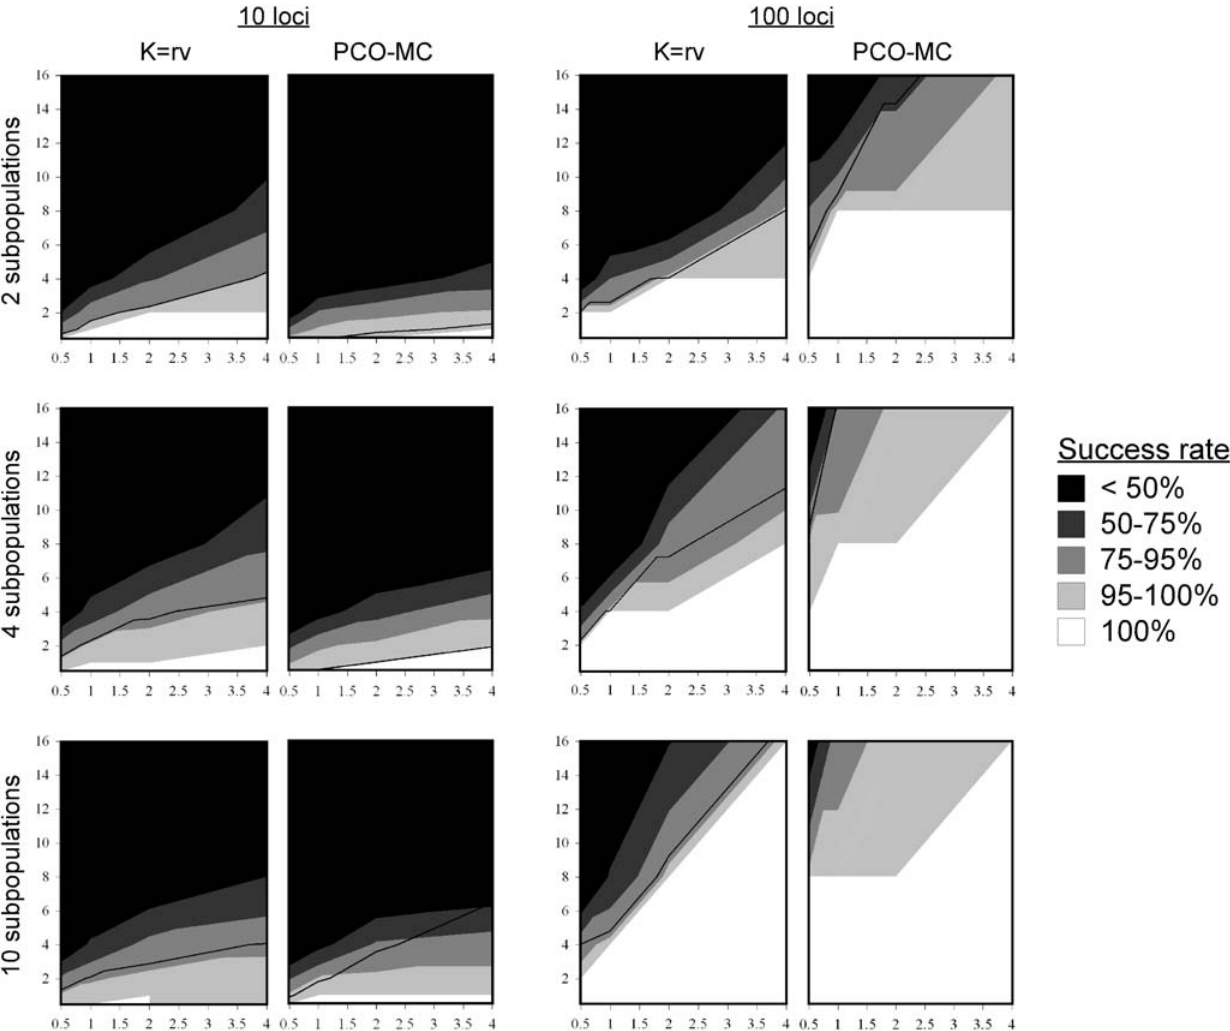
Figure 6. Relative performance of K=rv and PCO-MC methods for population structure inference using simulated data. X axes=mutation rate ( h ), Y axes=migration rate (M). Contour intervals are shaded according to the probability of successful inference. Below the thin black line, Type I error was acceptable ( a , 0.05). Type I error was , 0.05 for all combinations of h and M when PCO-MC was applied to the 100 locus, 10 population data